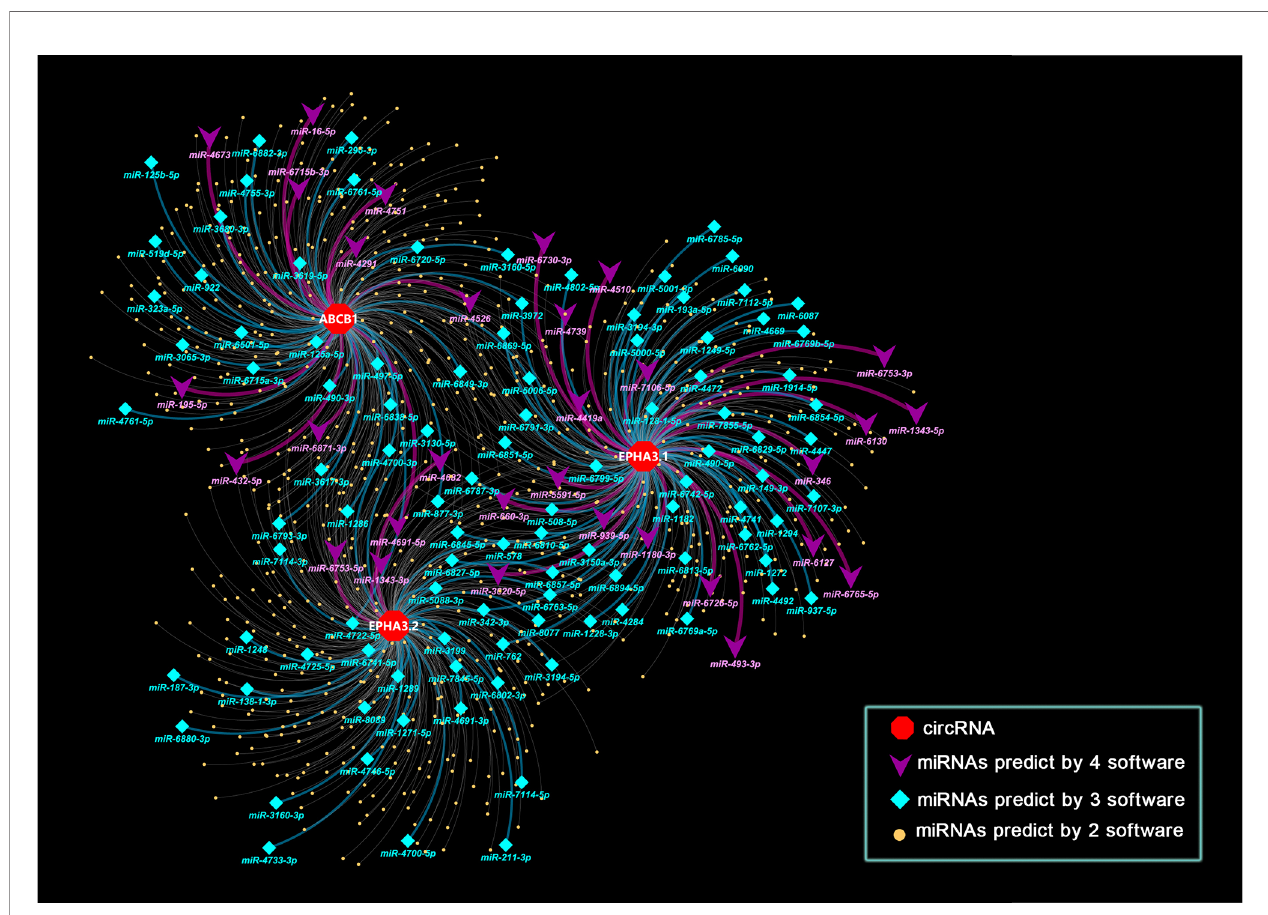
FIGURE 4 | Interaction network of three circRNAs and miRNA. Nodes in the plot represent a circRNA or a miRNA in the interaction network, edges in the plot represent the binding of miRNAs to circRNA. Attributes of the nodes are represented by shape and color. Red hexagons represent circRNAs. Purple triangle nodes indicate microRNAs that target circRNAs as predicted by 4 software tools. Cyan diamond nodes indicate microRNAs that target circRNAs as predicted by 3 software tools. Yellow dots indicate microRNAs that target circRNAs as predicted by 2 software tools. The color of the edges also indicates the number of tools used. Purple indicates that 4 software tools predicted the relationship, while cyan indicates 3 tools and light grey indicates 2